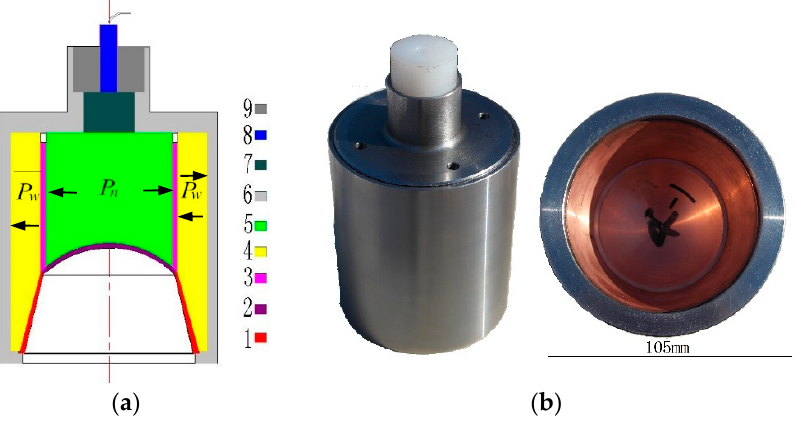
Figure 1. Schematic diagram of charge ( a ) and physical object of shaped charge based on the explosive pressure-coupling constraint principle ( b ). 1—Truncated cone; 2—spherical segment; 3—restraint cylinder; 4—external explosive column; 5—internal explosive column; 6—shell; 7—booster explosive; 8—detonator; 9—lightning tube socket.